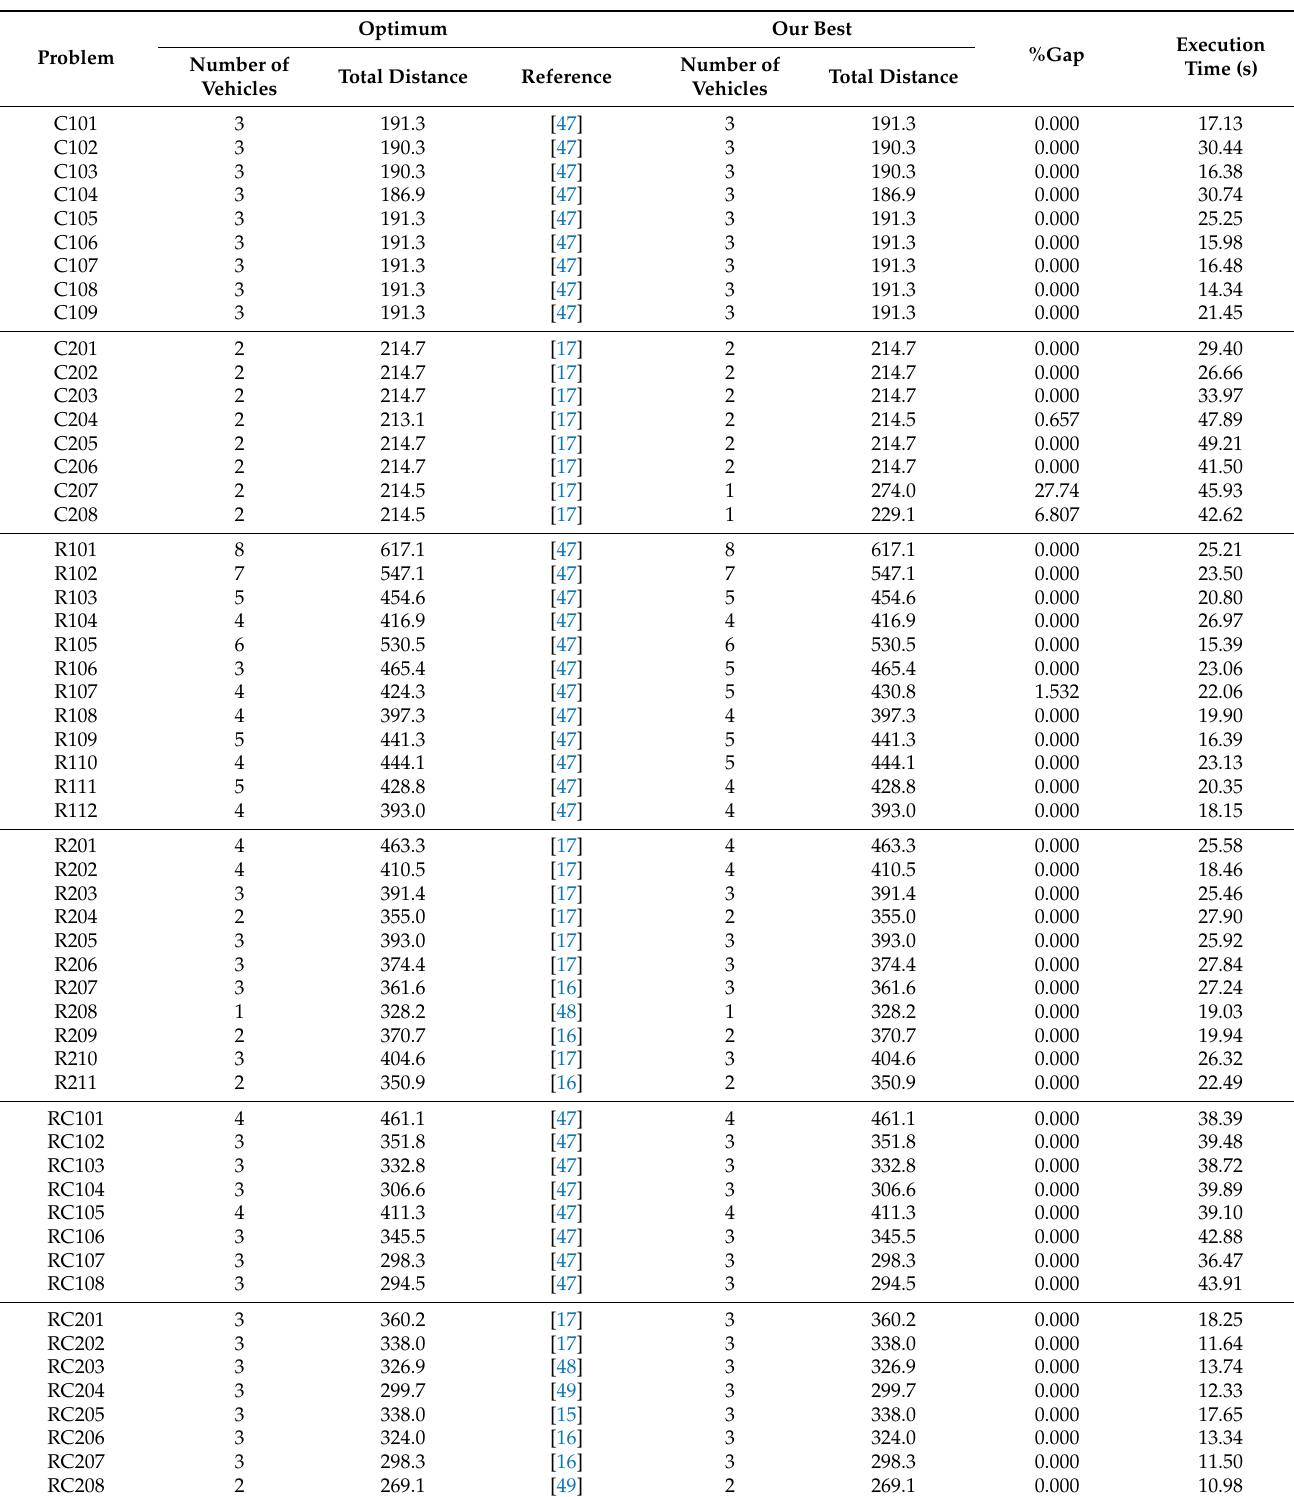
Table 3. Comparisons between the exact solutions and the results obtained by our heuristic on 25-customer Solomon